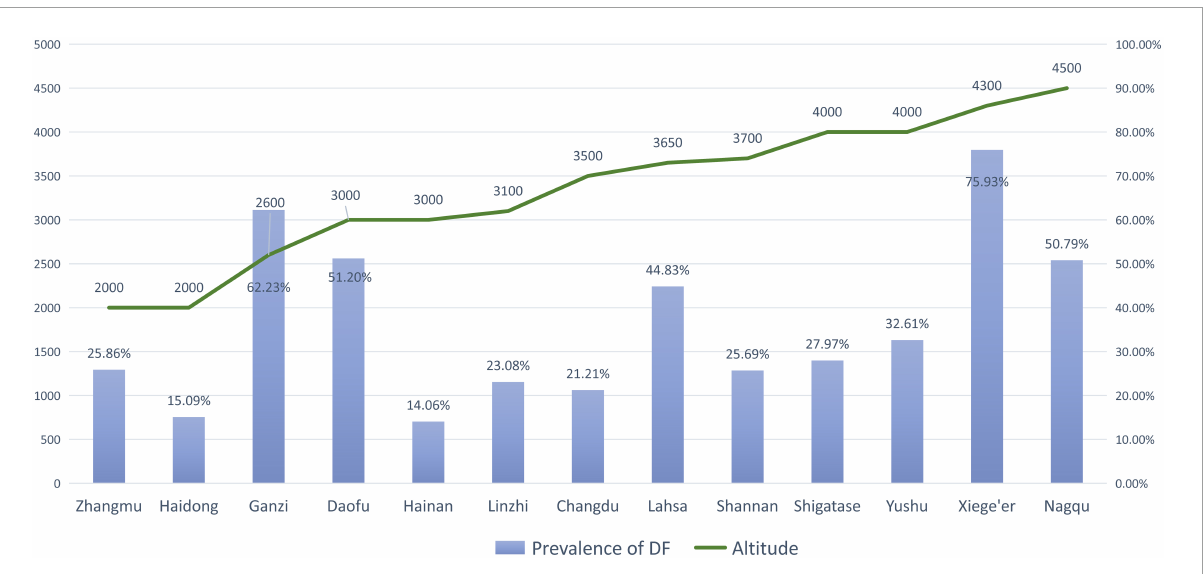
FIGURE3 The prevalence of dental fluorosis (DF) and the altitude of surveyed areas (The line graph shows the altitude of the research site, and the bar graph shows the reported prevalence of DF at the research site).